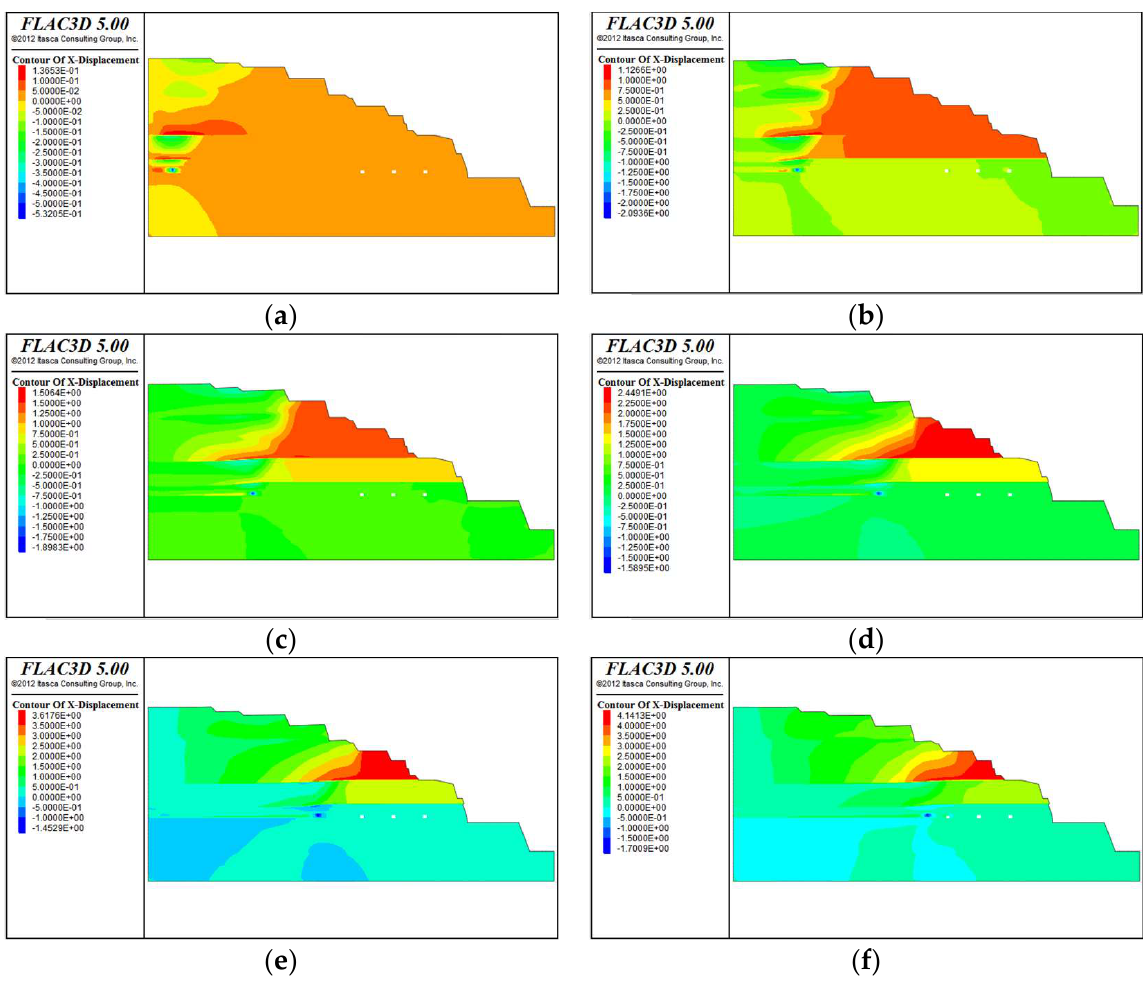
Figure 7. Horizontal displacement nephogram of the disturbed slope as the working face advances. ( a ) Advancing distance = 30 m; ( b ) advancing distance = 80 m; ( c ) advancing distance = 130 m; ( d ) advancing distance = 180 m; ( e ) advancing distance = 210 m; ( f ) advancing distance = 240 m. When the working face advances to 180 m, the parts of the steps from Step 1359 to 1404 denote the upper steps, Steps 1287 to 1359 represent the middle steps, and Steps 1258 to 1269 denote the lower steps. The maximum horizontal displacement occurs at Step 1315, which is 2.42 m. When the working face continues to advance to 200 m, Steps 1355 and 1359 are within the boundary and become the upper steps (Figure 8). Figure 6 shows that ① the horizontal displacement curves of steps in all parts are similar, indicating that